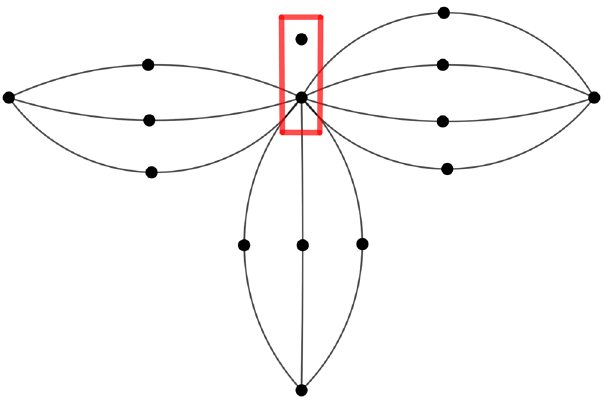
Figure 1: An illustration for the graph ( ) S 3, 3, 4 3 . The thick red box represents two false twin